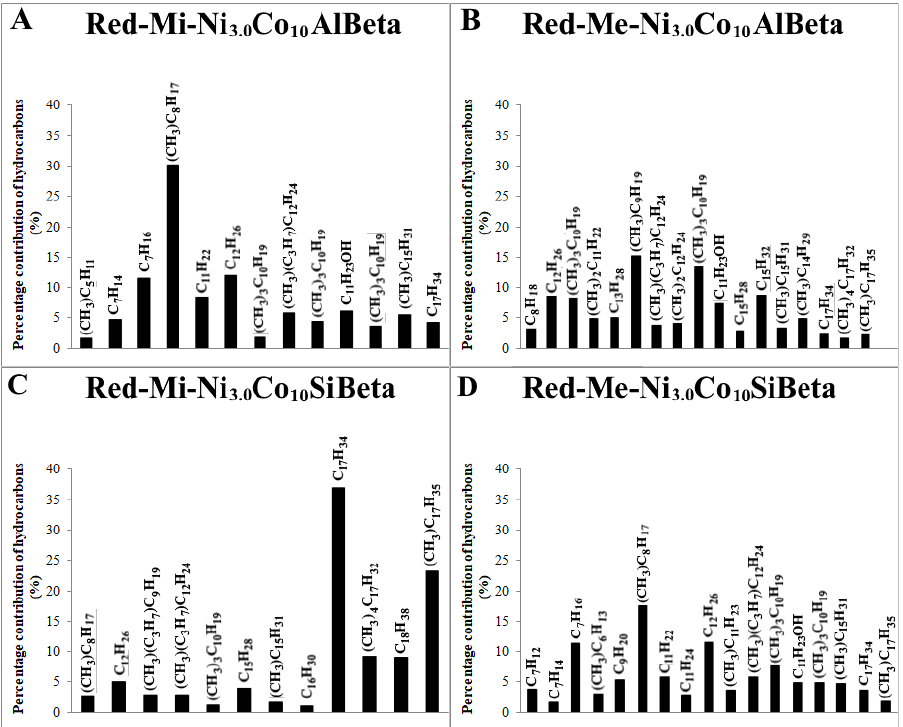
Figure 10. GC–MS analysis of liquid products achieved in FTS over ( A ) Red-Mi-Ni 3.0 Co 10 AlBeta, ( B )